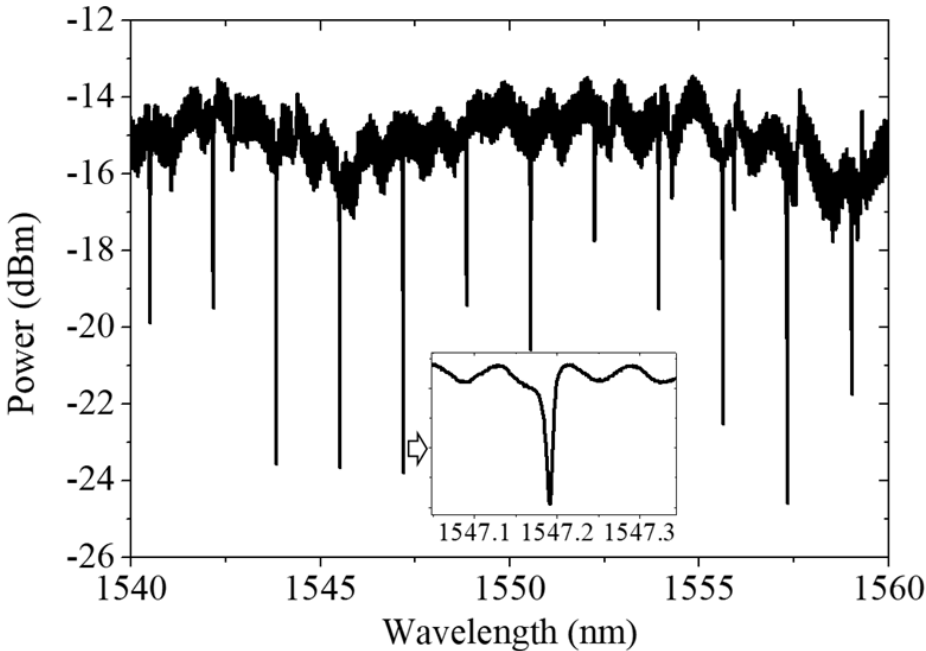
Figure 3. The measured optical transmission spectrum of the air-cladded SiN waveguide resonator and the zoomed-in spectrum (inset).